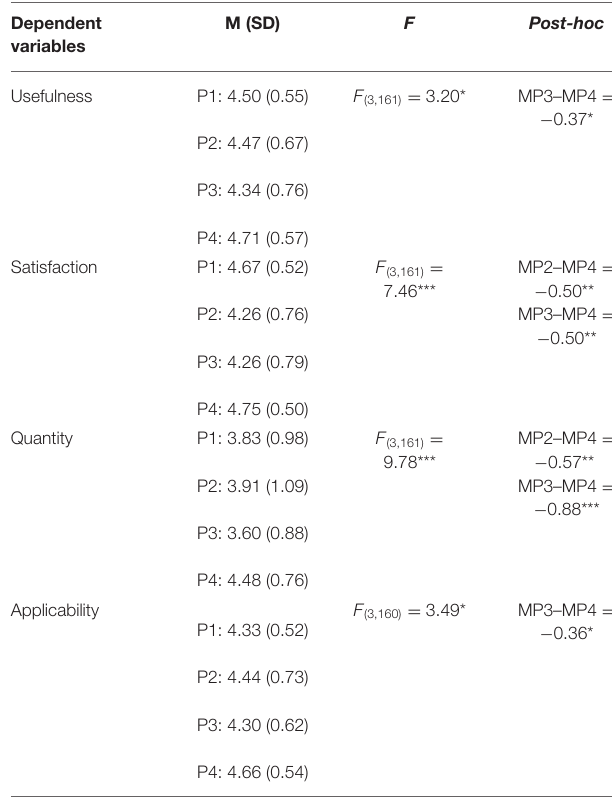
TABLE 4 | One-way ANOVA of the mediating variables according to the variable “participants in the reflection.” Dependent variables